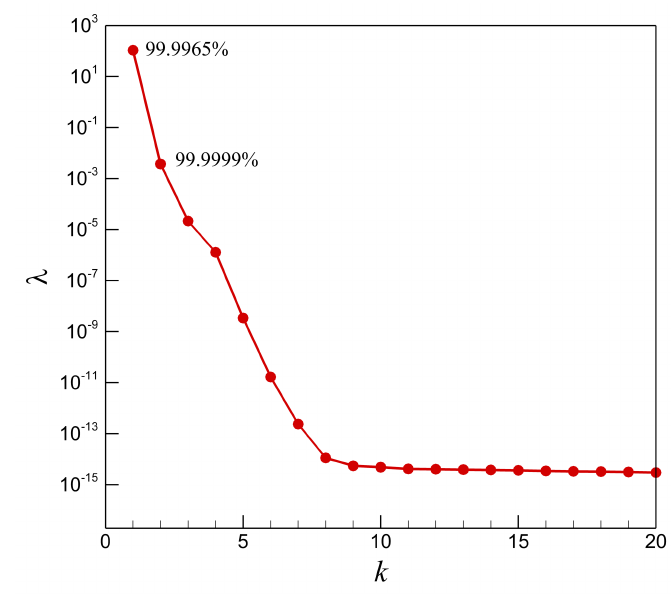
Figure 2. Eigenvalues of the correlation matrix of u field data.